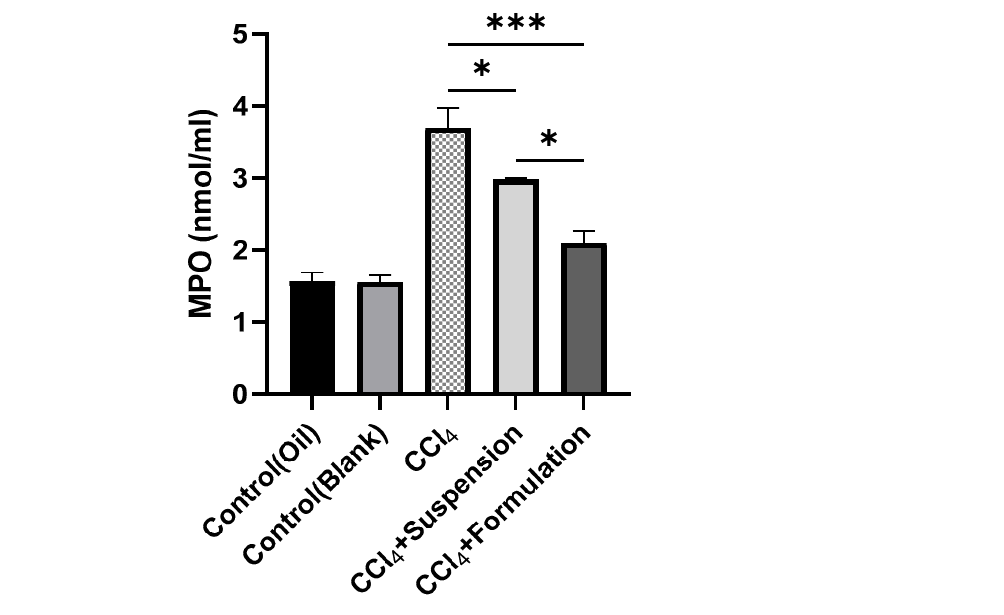
Figure 9. Effects of B. lacera leaf extract and its liposomal preparation on myeloperoxidase (MPO) activity. Data are presented as mean ± SEM, n = 6. where * p ≤ 0.05, *** p ≤ 0.001, when compared between the CCl 4 , CCl 4 + suspension and CCl 4 + formulation (liposomal) groups. p ≤ 0.05 was considered statistical level of significance for all cases.